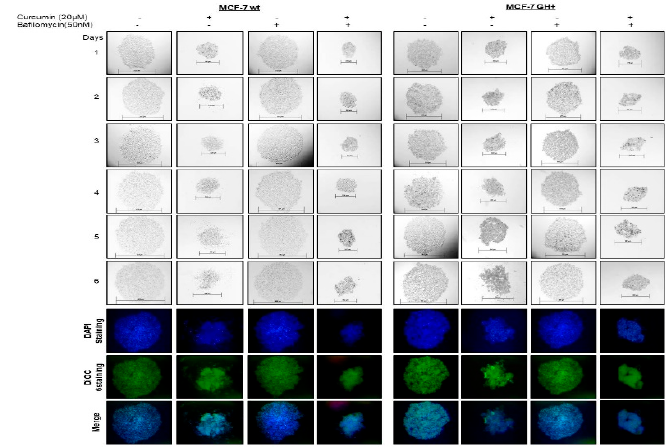
Figure 3. Bafilomycin increased curcumin-mediated invasion-metastasis prevention in autocrine GH expressing MCF-7 breast cancer cells. (Dioc6: Termo Fisher Scientific, D273, Waltham, MA,